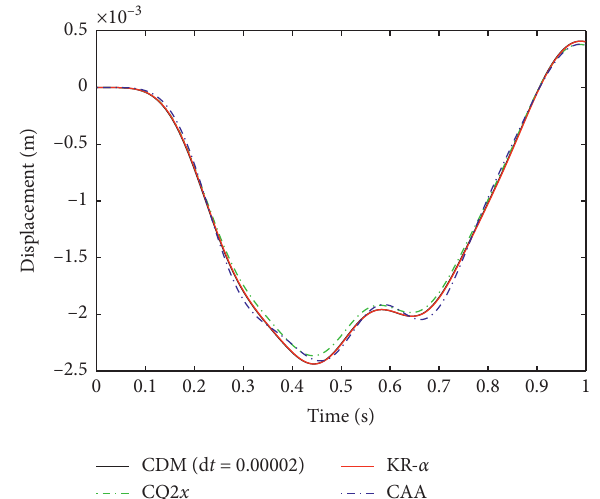
Figure 36: Deflection of the spring mass.